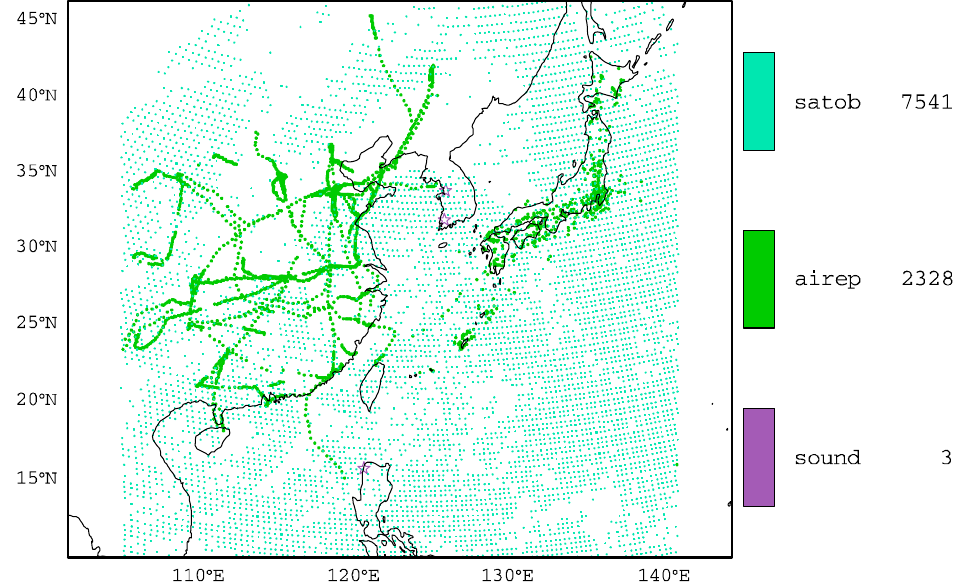
Figure 3. Distribution of GTS observations. Satellite atmospheric motion vector (SATOB), aircraft data (Airep), radiosondes (SOUND)